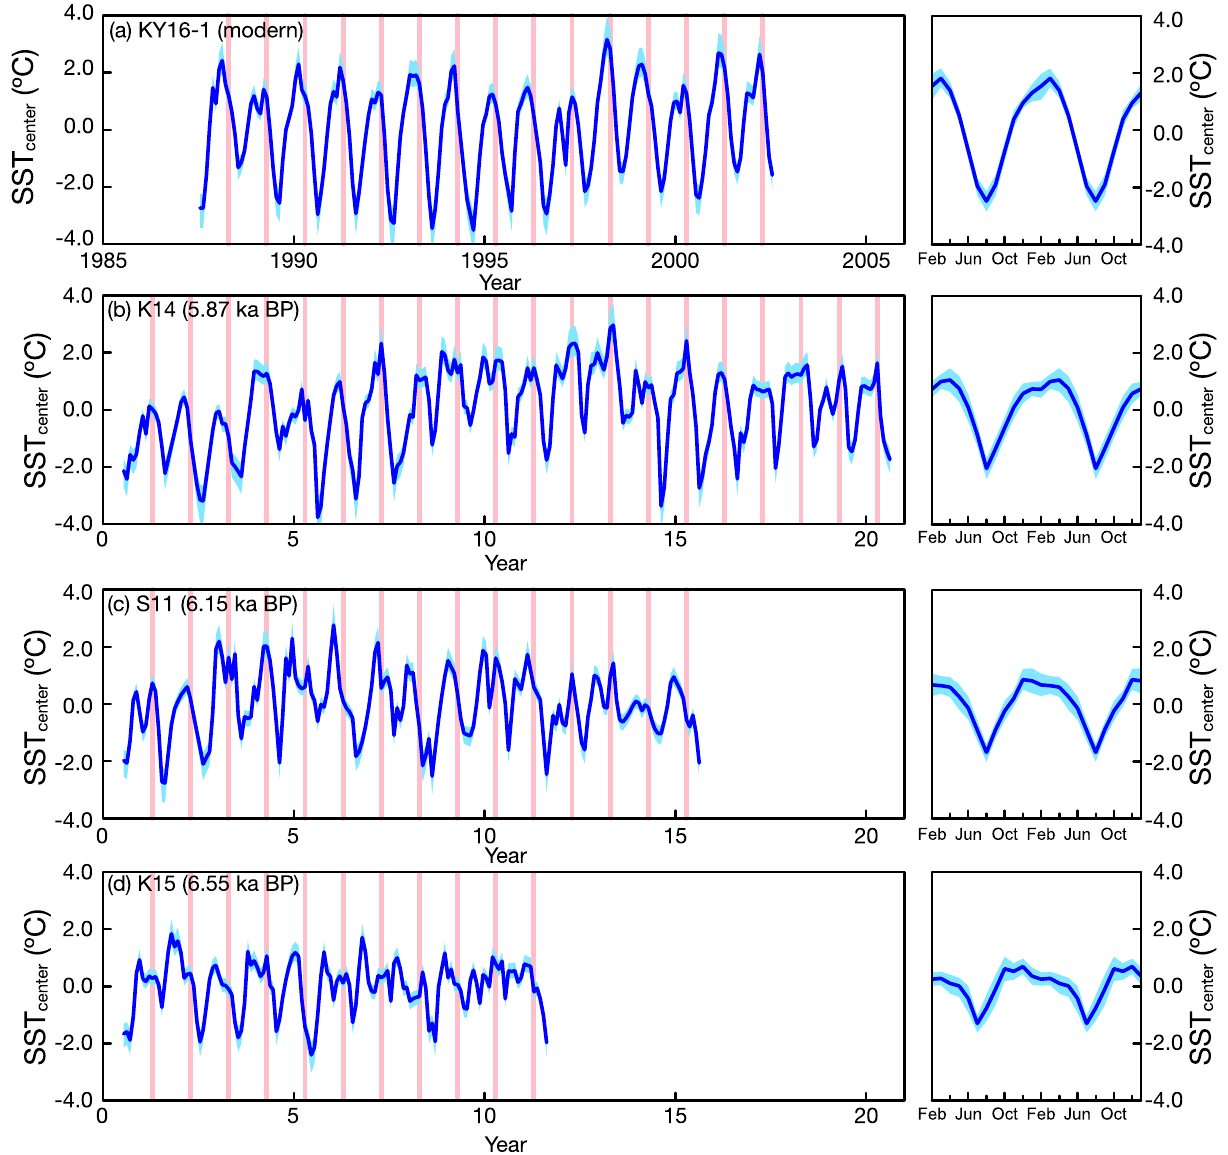
Figure 3. Modern and MH coral SST seasonality at Kenya. Monthly SSTs inferred from coral Sr/Ca (blue line, left) and mean seasonal cycles (right) calculated by averaging over all years for ( a ) modern coral KY16-1 and ( b–d ) the mid-Holocene corals S11 ( b ), K14 ( c ), K15 ( d ). Coral SSTs were derived from coral Sr/Ca by centering and conversion into SST units (°C) using a factor of −0.06 mmol/mol per 1 °C 26,27 . Uncertainty envelops (shading, 90% confidence intervals) for SST center (left panels) were estimated using a Monte Carlo approach 27 and included analytical and Sr/Ca-SST slope uncertainties . Uncertainty envelopes (shading, 90% confidence intervals) of the mean seasonal SST center cycles (right panels) are estimated with a bootstrap method with 20,000 loops and include the distribution around the mean SST values of each month, the slope uncertainty of the Sr/Ca thermometer and the analytical uncertainty of coral Sr/Ca (the latter two contributions are small). Red shading marks April (boreal spring). Modern SST maxima ( a ) occur in boreal spring. The majority of SST maxima in the 6 ka BP corals occur in boreal fall ( b–d